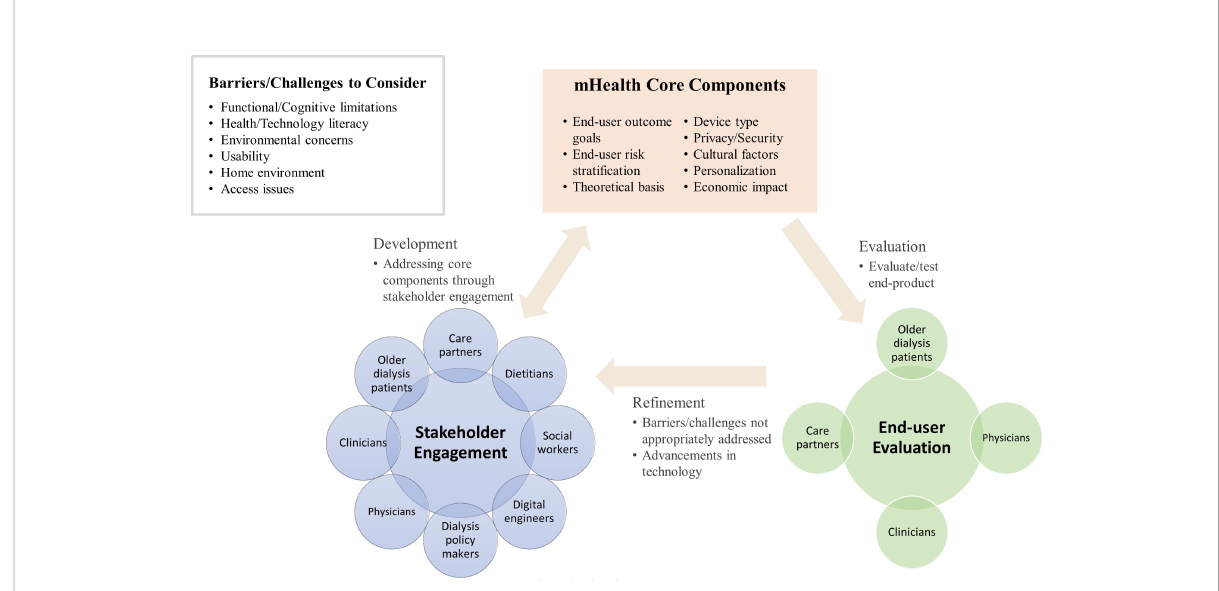
FIGURE 1 Conceptual model for a person-centered approach to the development of mHealth for older adults on dialysis and their care